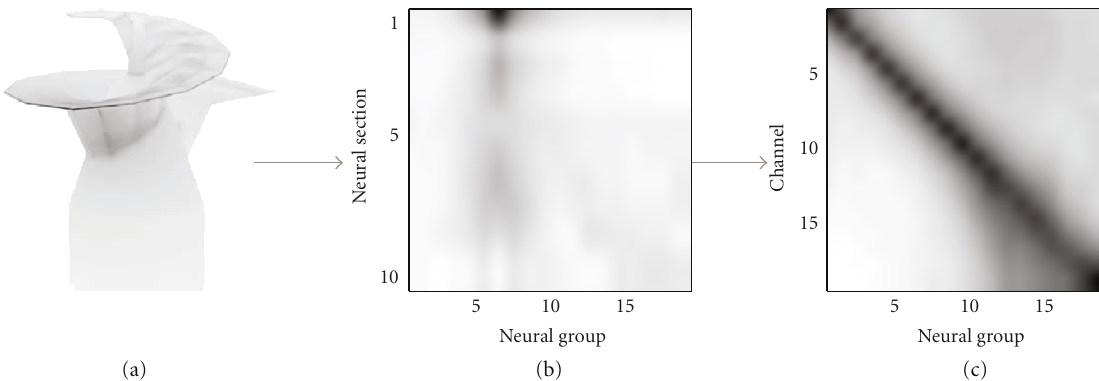
Figure 4: Results from the electric field simulation. The activation over the cochlear nerve tissue during a unit impulse from electrode position 7 (a) is mapped to the activation matrix A 7 (b). A matrices are combined to form the matrix T (c), here with c k = 1 for all k . The electrodes and neural groups are indexed in basal to apical direction and the neural sections in peripheral to central direction.